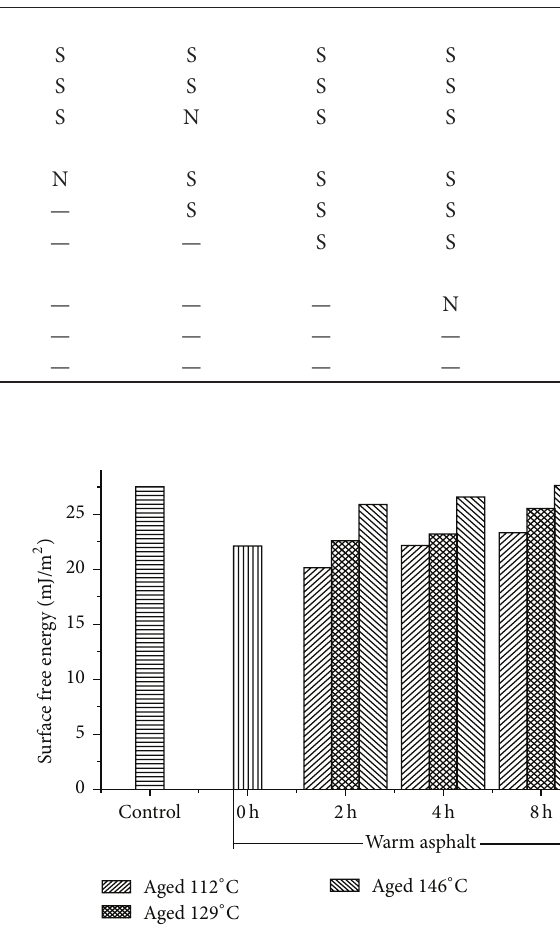
Figure 5: Change in SFE as a function of aging temperature and